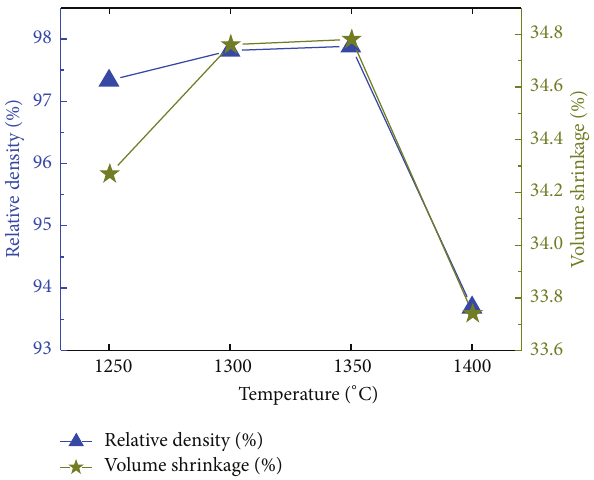
Figure 3: The volume shrinkage and relative density alteration of CaTiO 3 against sintering temperature.